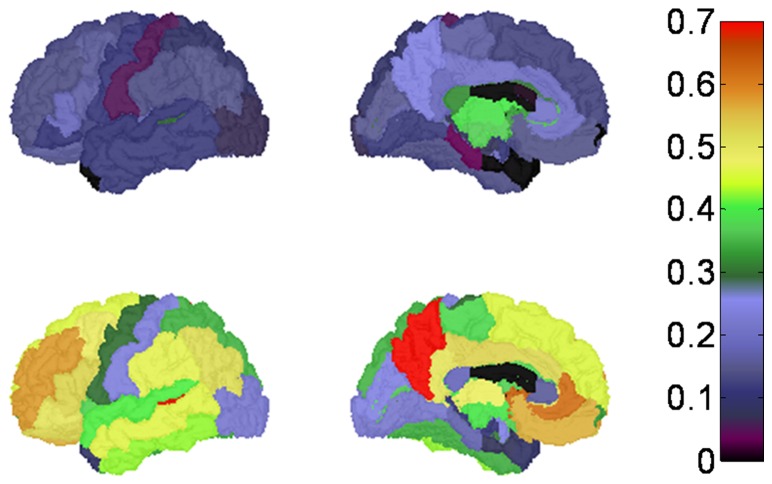
Average regional amyloid deposition for the CDR0 group (top row) and the CDR+ group (bottom row) quantified using FreeSurfer regions. For each group the lateral (left) and medial (right) surfaces of the left hemisphere were illustrated.